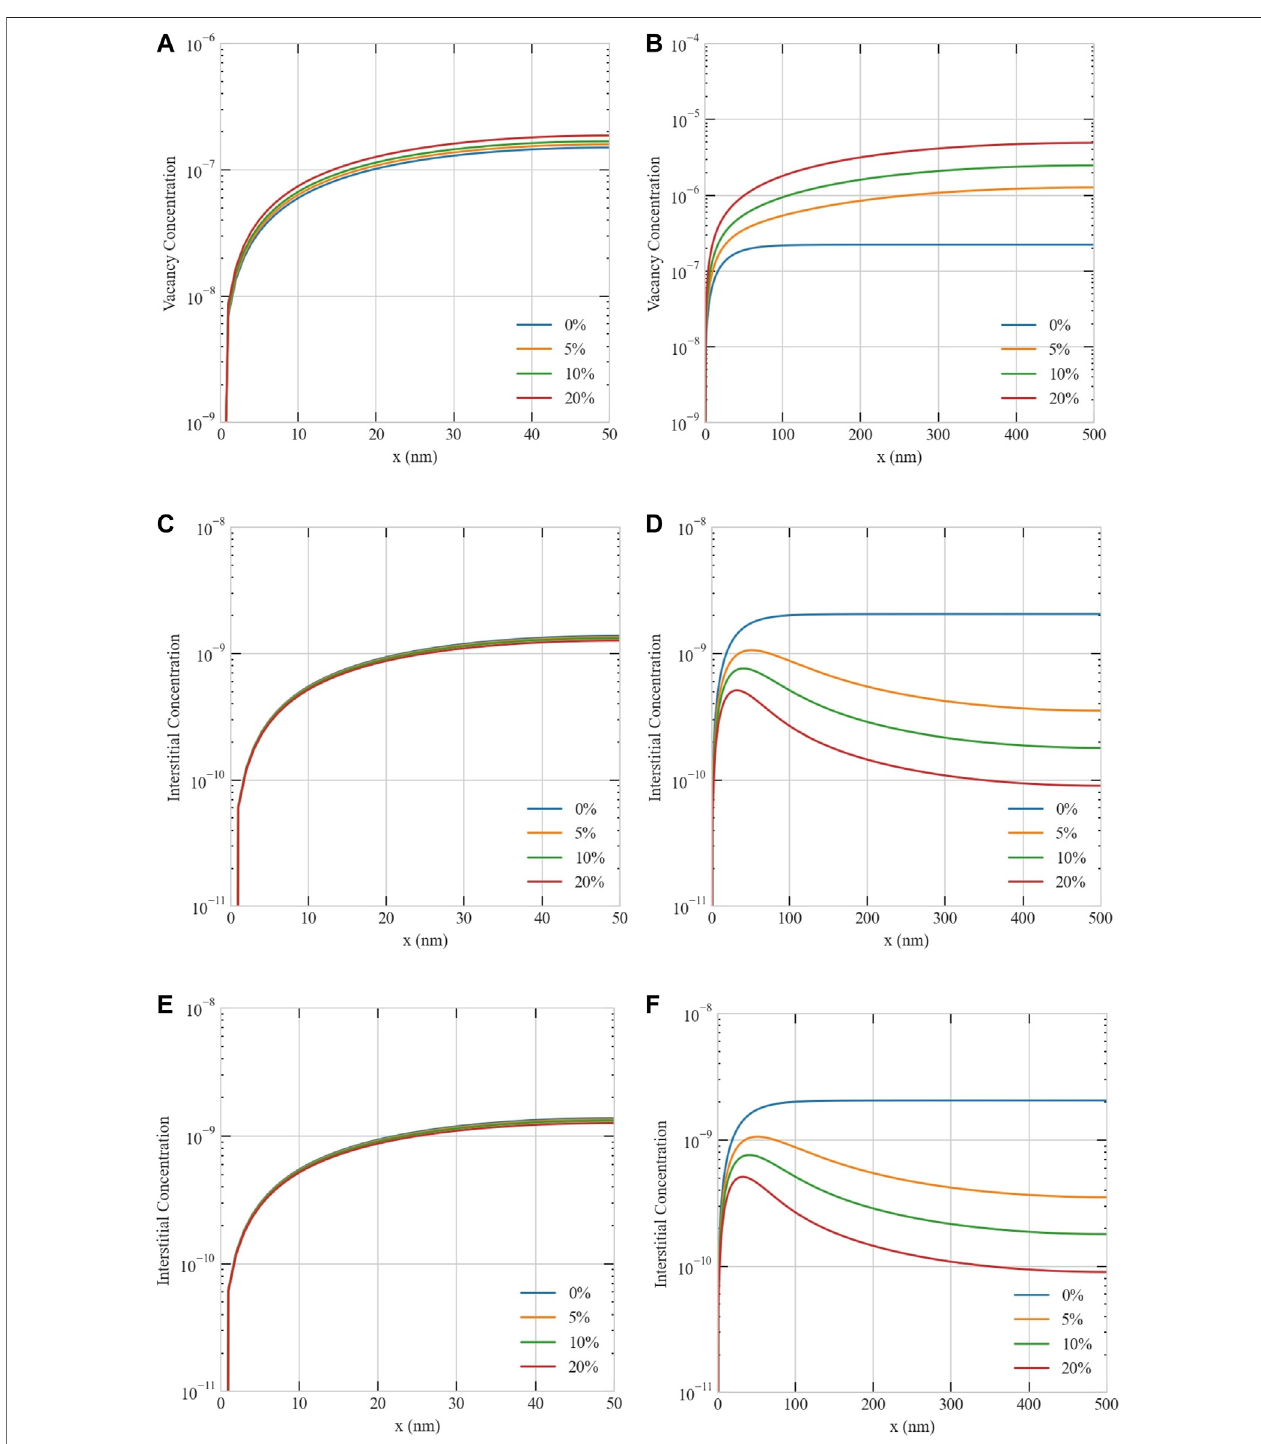
FIGURE13| Effectofproductionbiasonthesteady-stateconcentrationpro fi lesofpointdefectsinNi-Crat1e-3 dpa/s. Upperrow :vacancyconcentrationfor (A) 50 nmand (B) 500 nmgrains. Middlerow :interstitialconcentration (C) 50 nmand (D) 500 nmgrains. Lowerrow :chromiumconcentration (E) 50 nmand (F) 500 nm grains. The effect of production bias is more apparent at larger sizes because of the size-dependent instability discussed in section 3.1 .